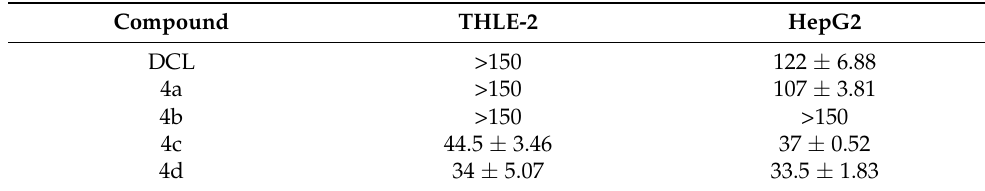
Table 1. Comparison of the DCL and DCL–OAO derivatives cytotoxicity in THLE-2 and HepG2 cells *.